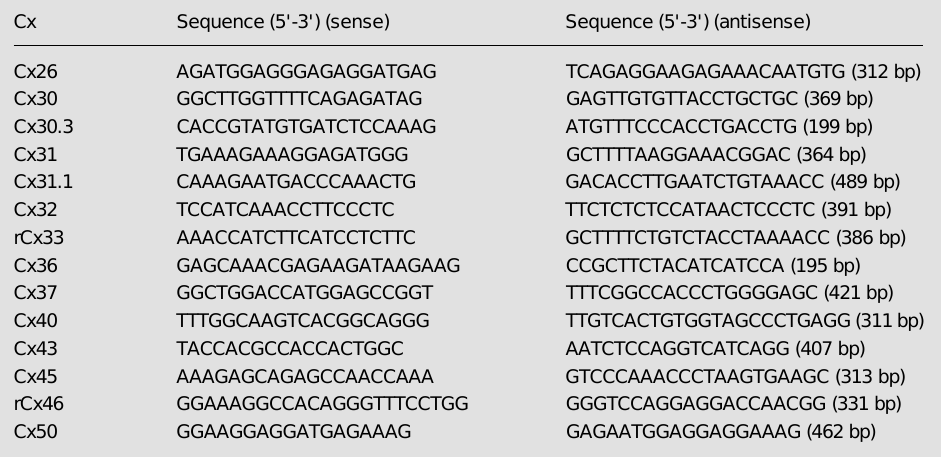
Table 3 - Connexin-specific primers routinely used to verify the expression of connexins expressed in mice (*except Cx33 and Cx46). *Mouse Cx33 and Cx46 sequences are not yet available (see Table 1); Cx33- and Cx46-specific primers are listed for rat sequences (e.g., rCx33 and